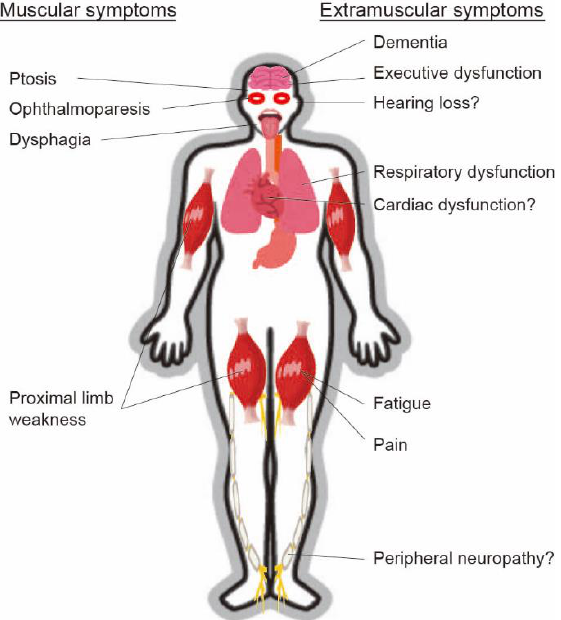
Figure 1. Various muscular and extramuscular symptoms of oculopharyngeal muscular dystrophy (OPMD). Patients with OPMD can manifest various muscular and extramuscular symptoms.